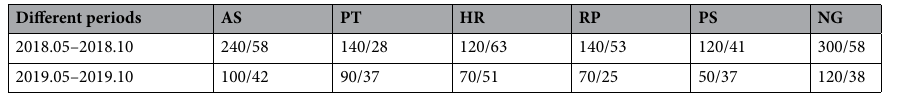
Table 4. The recharge depth (cm) and amount (mm) of soil moisture storage in different vegetation types.